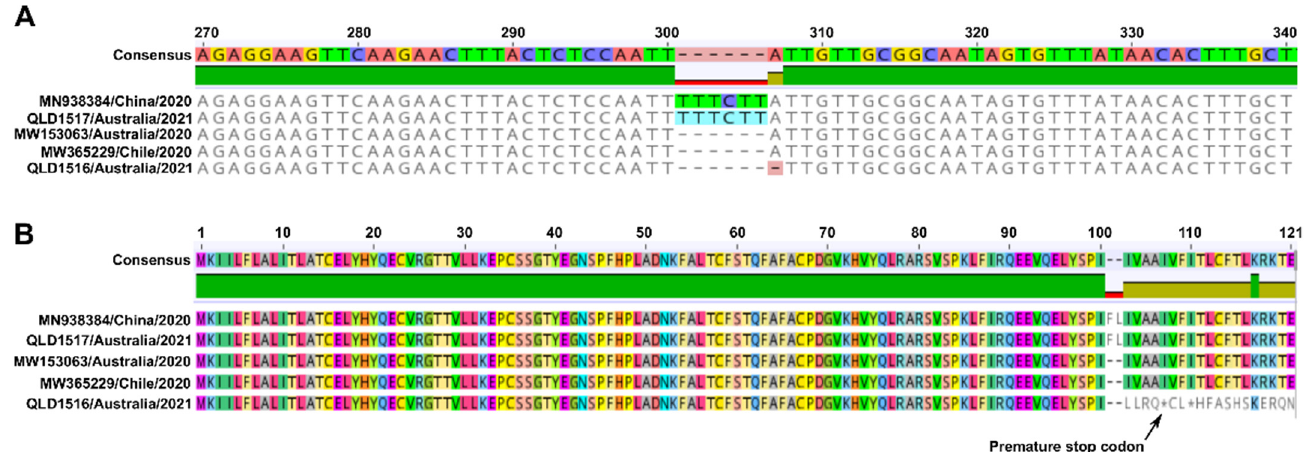
Figure 3. Partial nucleotide ( A ) and complete amino acid sequences ( B ) derived from the SARS-CoV-2 ORF7a gene B.1.1.7 VOCs, QLD1516/2021, and QLD1517/2021. The mutated QLD1516/2021 sequence containing a 7-nucleotide indel is compared with non-mutated sequences of QLD1517/2021 and Wuhan-Hu-1 (GenBank accession number MN938384) together with representative 2020 sequences from Victoria, Australia and Chile containing a 6-nucleotide indel (GenBank accession numbers MW153063 and MW365229, respectively). The position of the putative premature stop codon predicted in the QLD1516/2021 amino acid sequence is indicated by the arrow pointing to an asterisk.